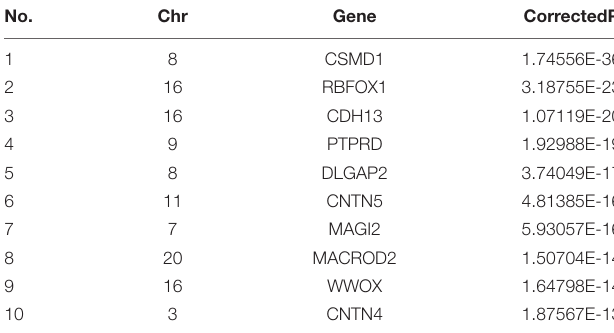
TABLE 3 | Top 10 conditionally significant genes were obtained. Chr represents Chromosome; Gene represents the gene name; CorrectedP represents P -value generated by Bonferroni correction.